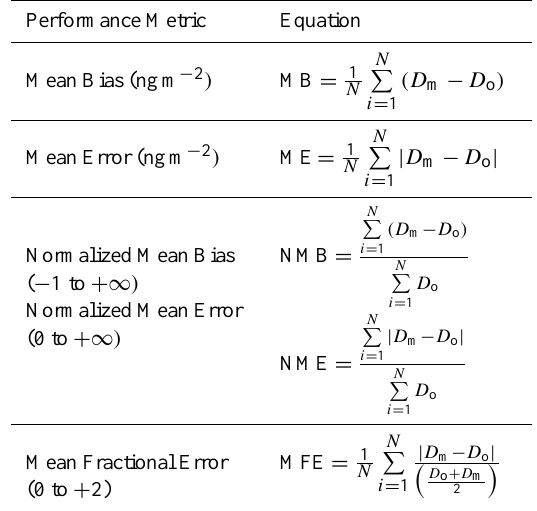
Table 2. Definition of Statistical Performance Metrics for Hg Deposition ∗